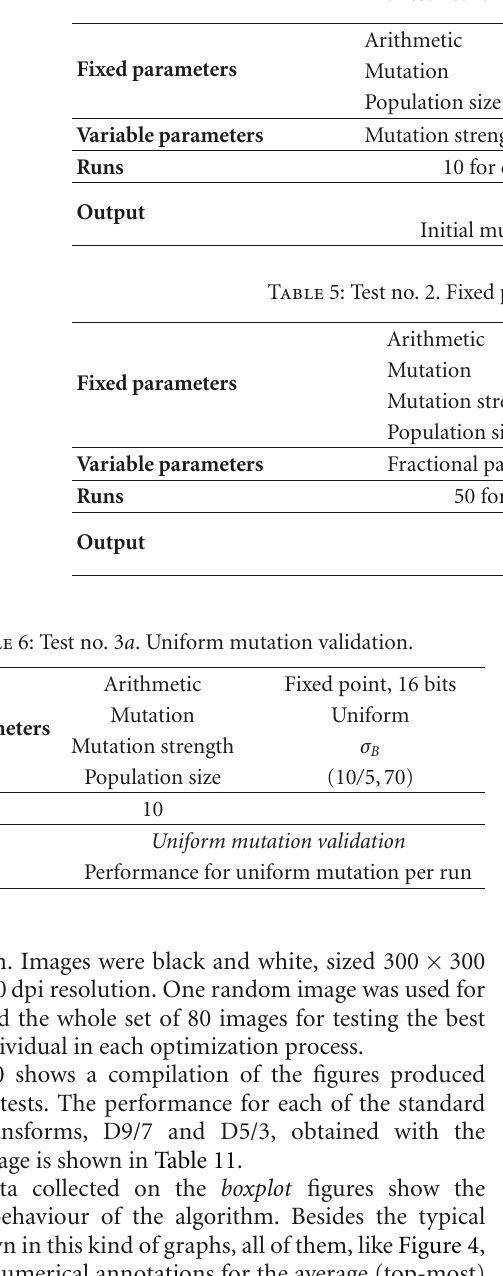
Table 4: Test no. 1. Initial mutation step σ .